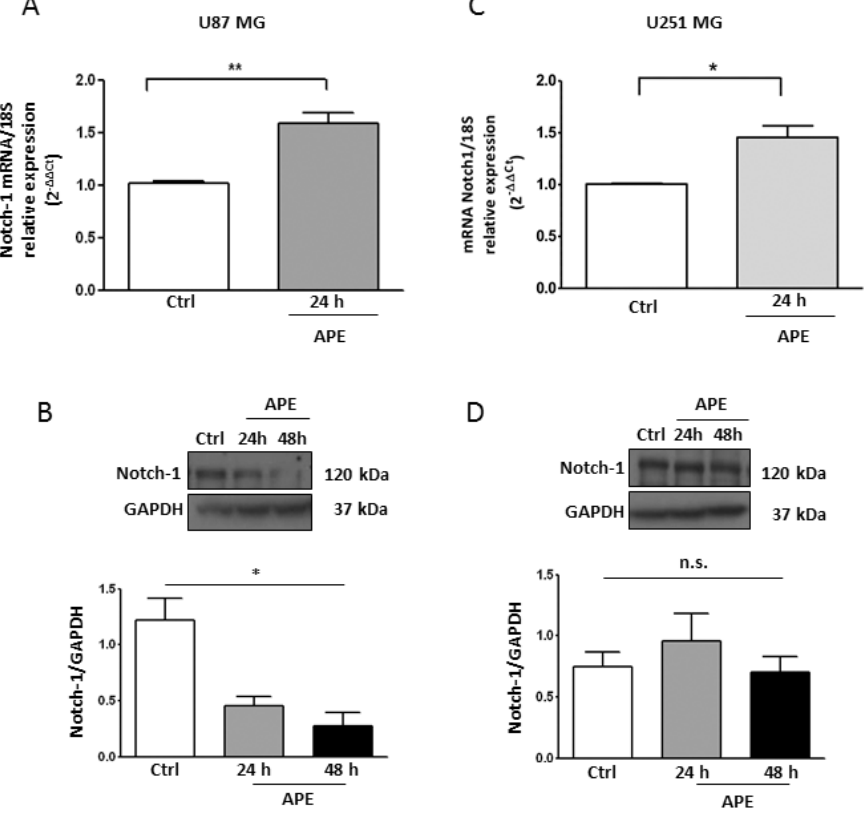
Figure 1. Notch-1 Expression in GBM cell lines. Real time RT-PCR and Western blot analysis ( A and B , respectively) for Notch-1 in U87MG and in U251MG cells ( C and D , respectively) cultured in the absence or presence of 100 µ M APE for 24 and 48 h. Representative blots are shown from three independent experiments. GAPDH was used as the internal reference protein (* p < 0.05, ** p < 0.01).